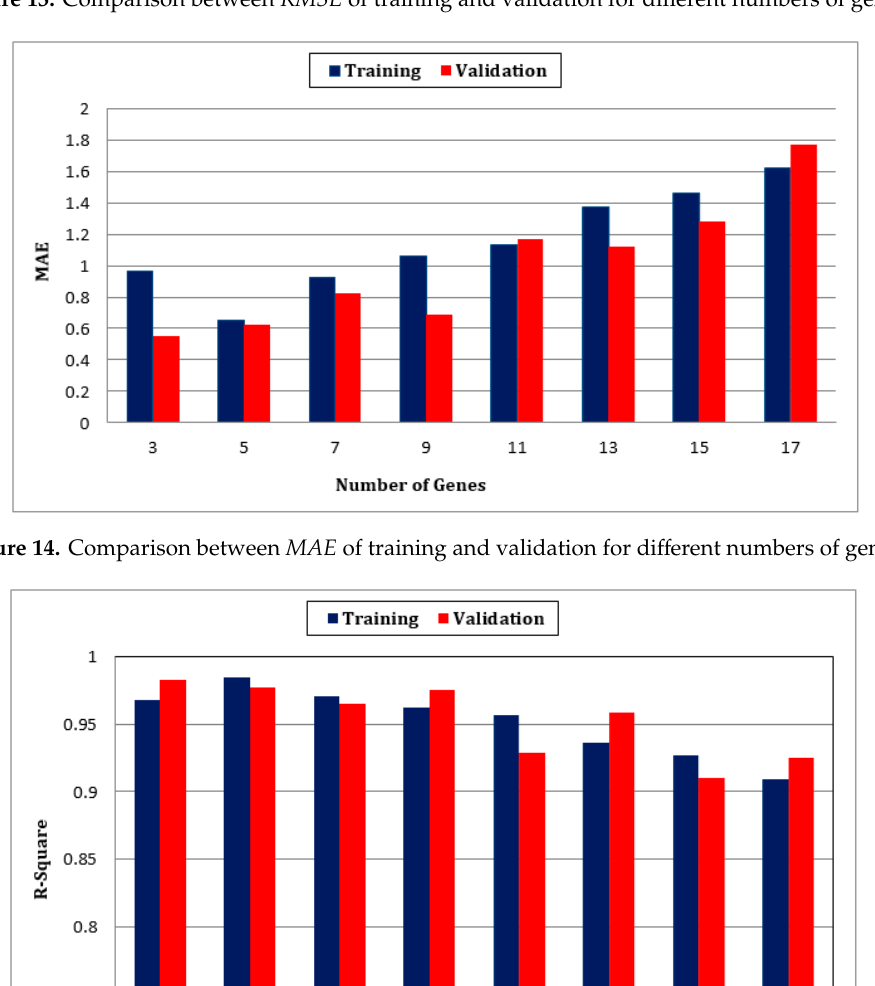
Figure 13. Comparison between RMSE of training and validation for different numbers of genes.